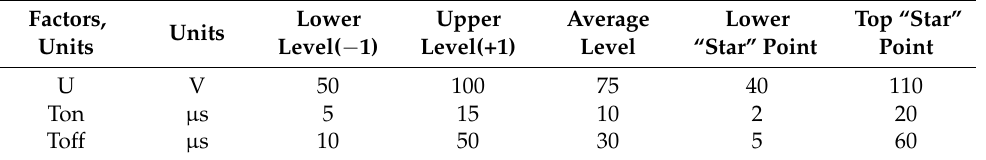
Table 2. Process parameters of wire-electrical discharge machining (EDM).